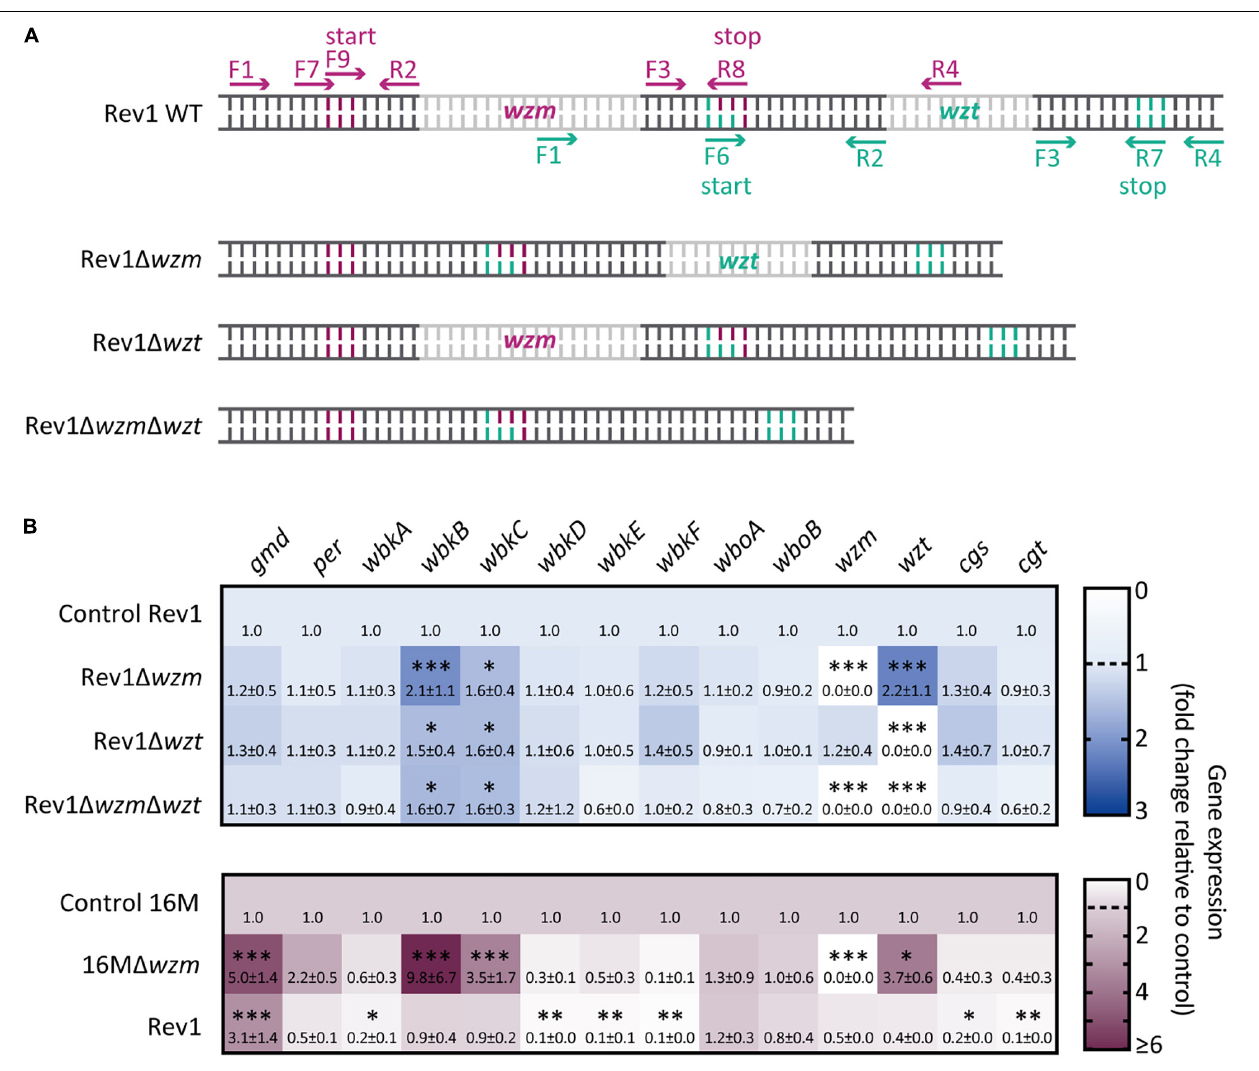
FIGURE 1 | Deletion of wzm and/or wzt leads to different transcriptional regulations of O-PS biosynthesis genes. (A) Schematic representation of the forward (F) and reverse (R) primers designed onto wzm (pink) and wzt (green) to delete their inner regions (gray), with the respective start/stop codons in the wild-type (WT) parental strain and resulting mutants. (B) Heat maps representing the mean values of the genetic relative expression (fold-change; mean ± SD) determined by qRT-PCR in Rev1 (cid:49) wzm , Rev1 (cid:49) wzt , Rev1 (cid:49) wzm (cid:49) wzt vs. Rev1 control (upper panel; n = 5), including 16M (cid:49) wzm and Rev1 vs. 16M control (lower panel; n = 2) for comparative purpose. Fisher’s LSD test: ∗∗∗ p ≤ 0.001, ∗∗ p ≤ 0.01, ∗ p ≤ 0.05 vs. Rev1 or 16M control (base line =